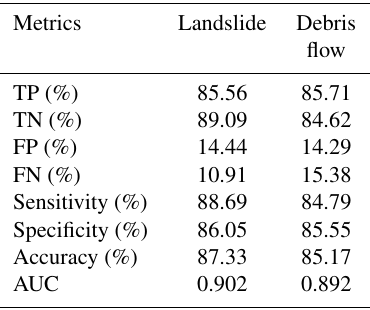
Table 2. Models’ performance using the verification